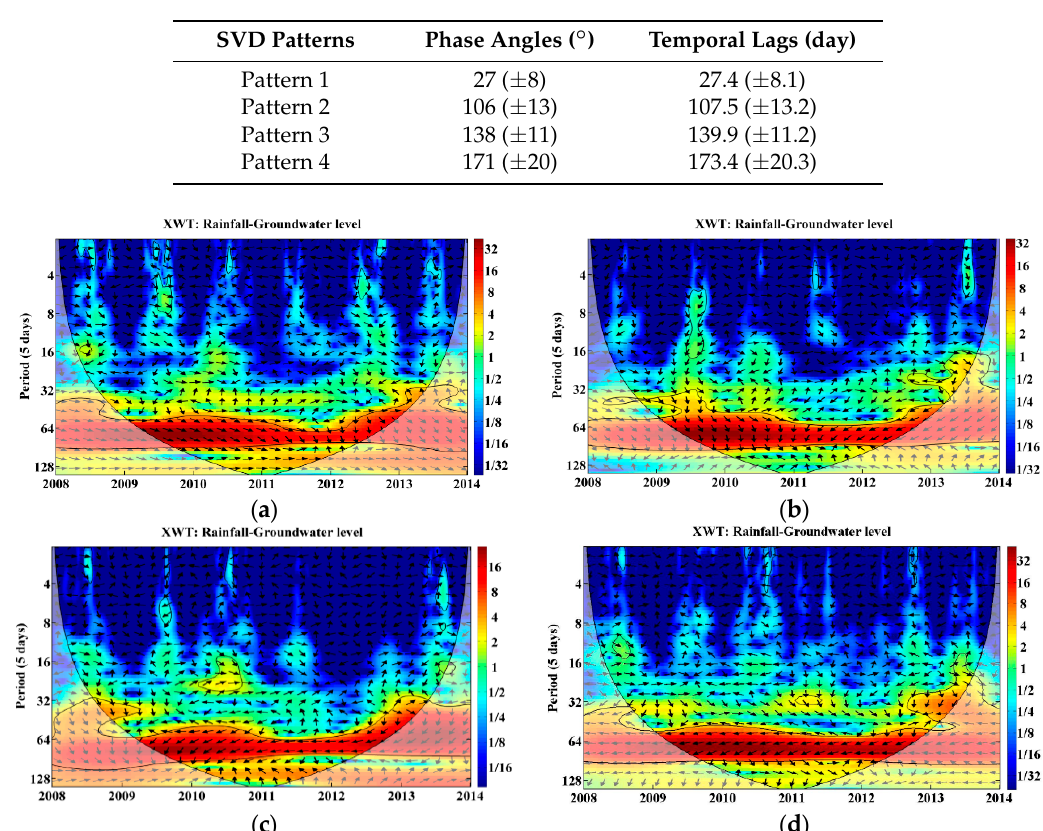
Figure 5. The cross-wavelet transform (XWT) between precipitation and groundwater in the Naoli River Basin, Northeast China, for pattern 1 ( a ), pattern 2 ( b ), pattern 3 ( c ), and pattern 4 ( d ), respectively. The significant level of 5% for red noise is displayed as a thick contour, and the relative relationship of phase is denoted as arrows (with anti-phase pointing left, in-phase pointing right).